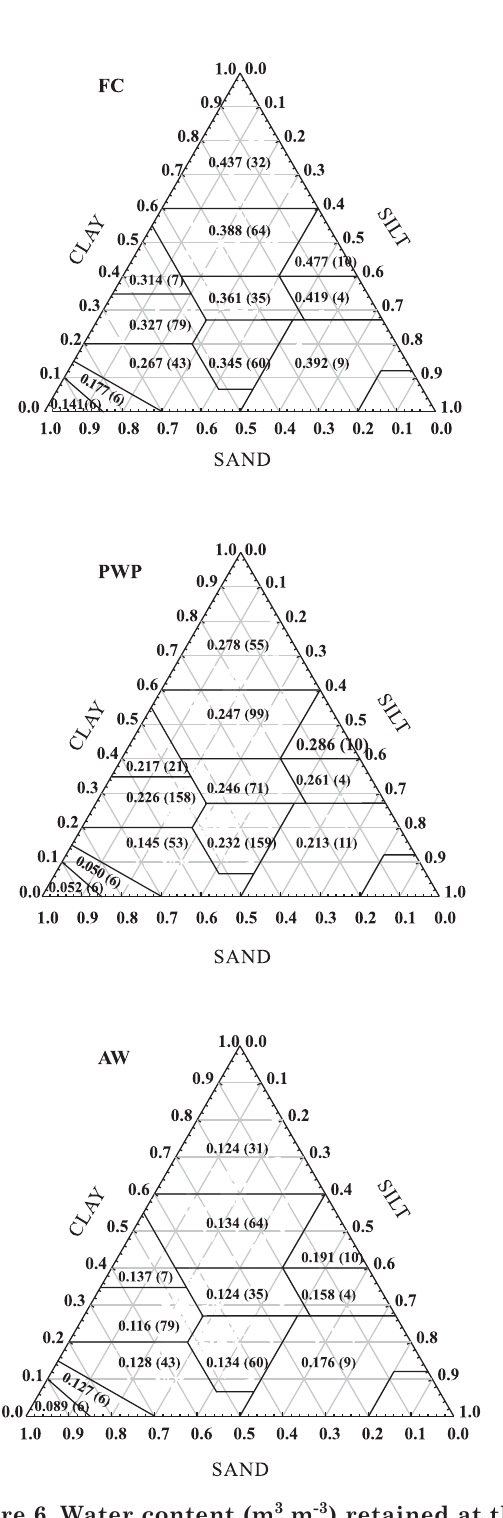
Figure 6. Water content (m 3 m -3 ) retained at the tensions of 10 kPa (FC) and 1,500 kPa (PWP) and plant-available water capacity retained between the tensions of 10 and 1,500 kPa (AW), at the mean of each soil textural class, calculated from measured data. In brackets is the number of samples available for calculating each mean.